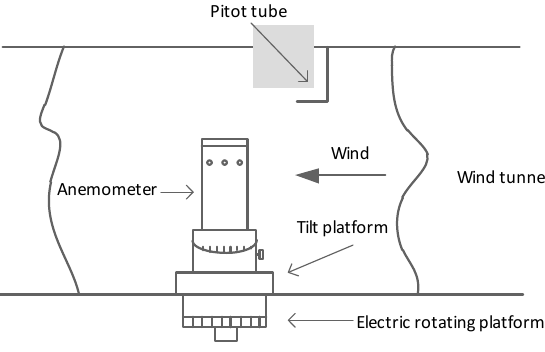
Figure 8. Standard wind tunnel for test prototype.